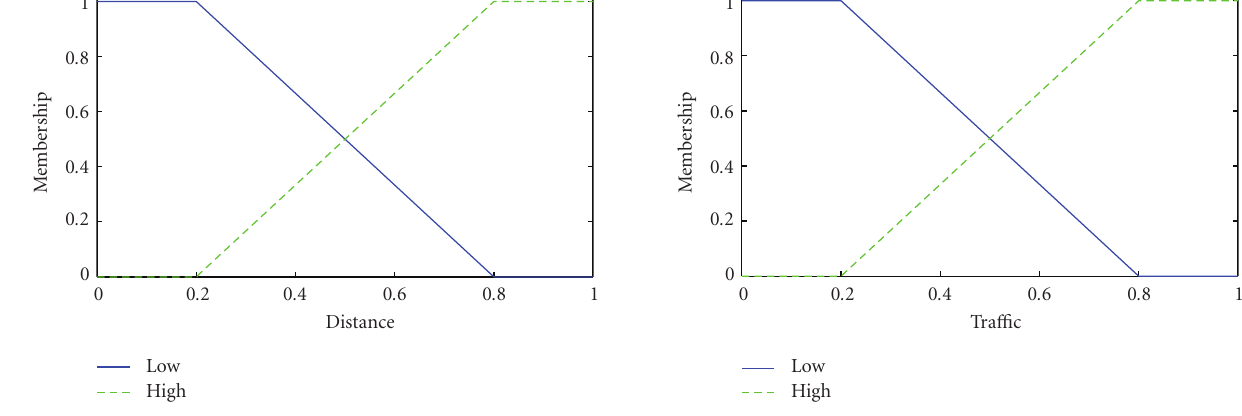
Figure 7: Membership function of “Distance” parameter. Figure 8: Membership function of “Tra ffi c”